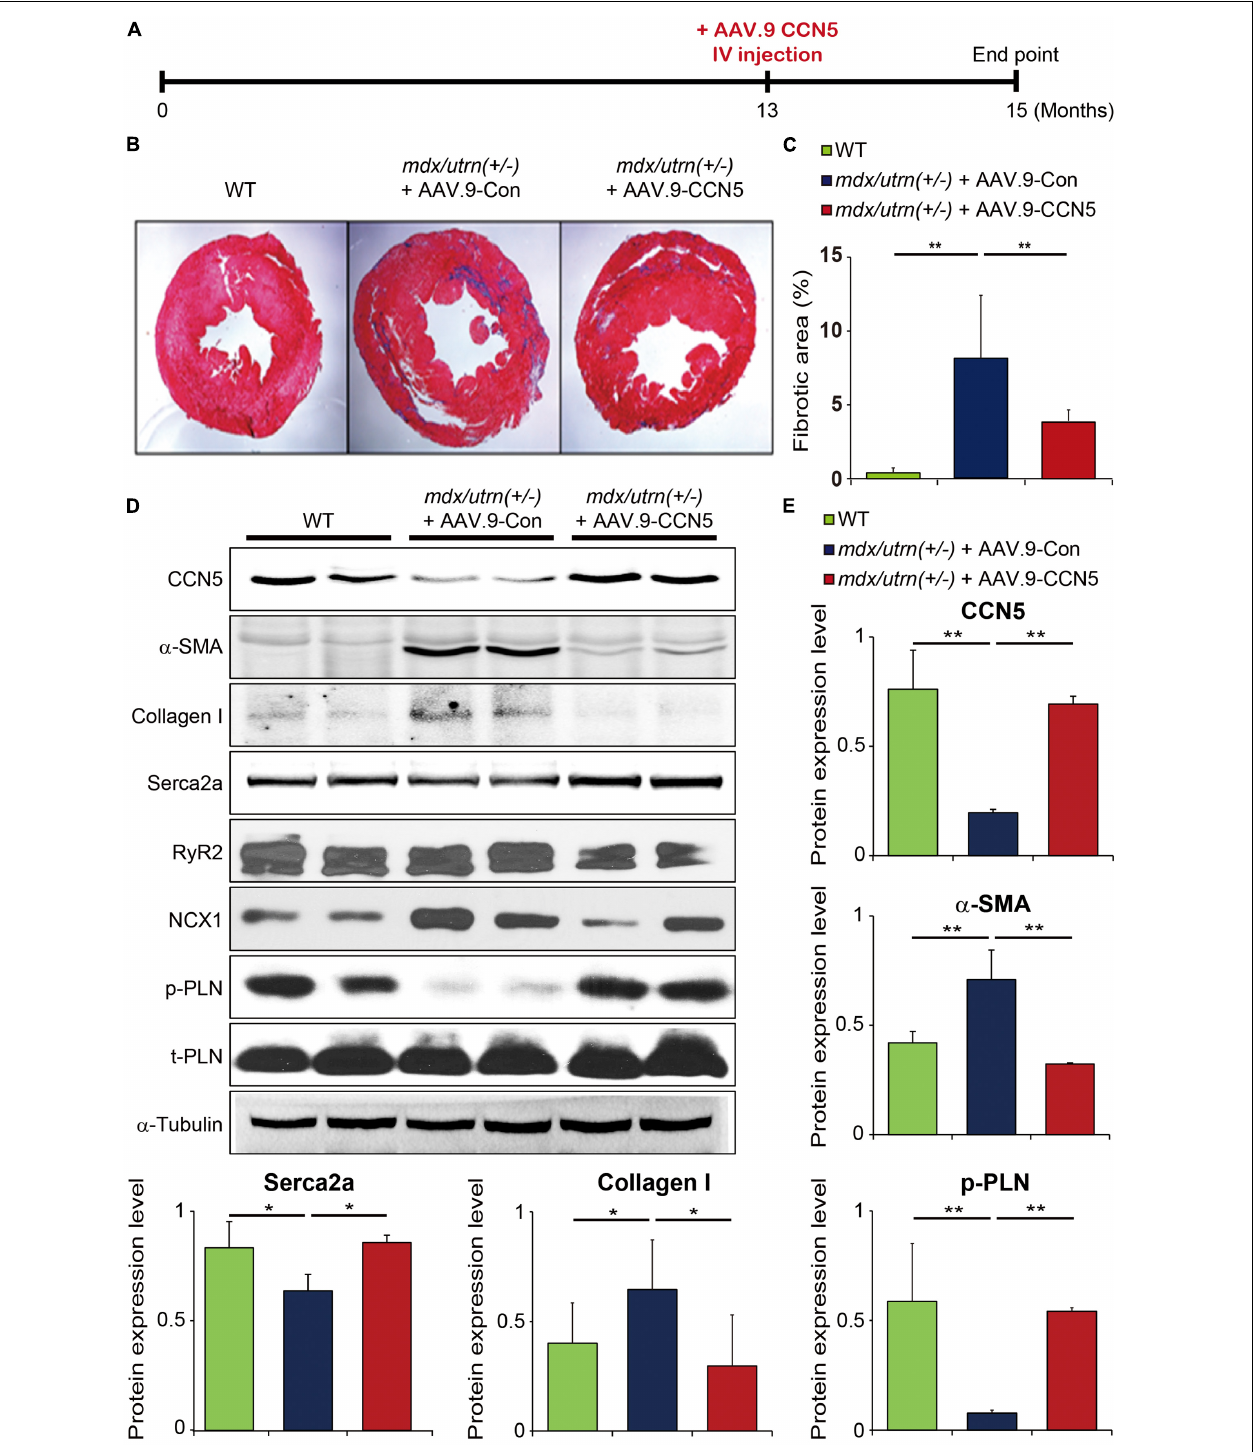
FIGURE 1 | CCN5 prevents cardiac fibrosis in mdx/utrn ( ± ) mice. (A) Experimental scheme for panels (B–E) . mdx/utrn ( ± ) mice were injected with AAV.9-Con or CCN5 into the tail vein, and hearts were harvested for experiments 8 weeks later. Age-matched WT mice are shown in comparison. (B) Hearts were sectioned and stained with trichrome. Blue areas indicate fibrotic tissue and red areas indicate normal tissue. (C) The ratio of fibrotic area over total tissue of the stained hearts was plotted. (D) Proteins obtained from cardiac tissue were immunoblotted with antibodies against CCN5, α -SMA, collagen I, SERCA2a, RyR2, NCX1, phosphorylated phospholamban (p-PLN), t-PLN and α -tubulin. (E) Protein bands on western blots were scanned and plotted. n = 6. * p < 0.05 and ** p < 0.01.